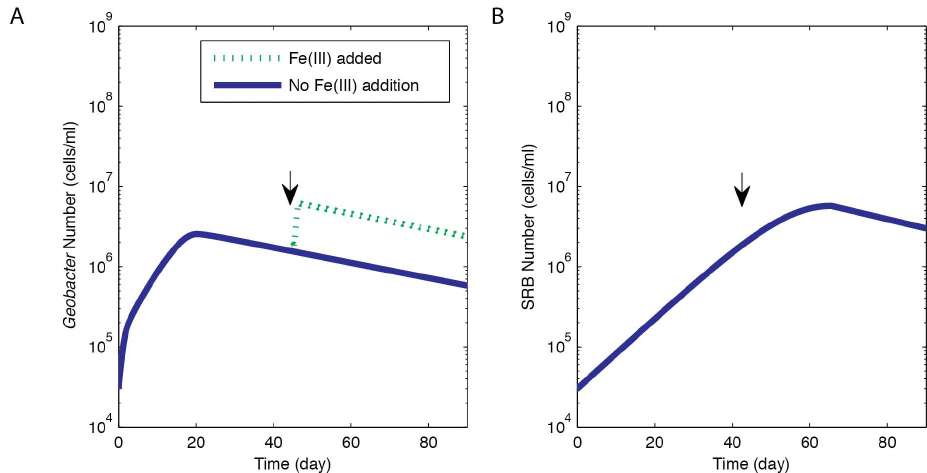
Fig. 4. Predicted impact of adding Fe(III) on the number of Geobacter (A) and SRB (B) . The different line style and markers distinguish the control simulation where no Fe(III) was added from the simulation where Fe(III) was added. The black arrows indicates the day Fe(III) was added.